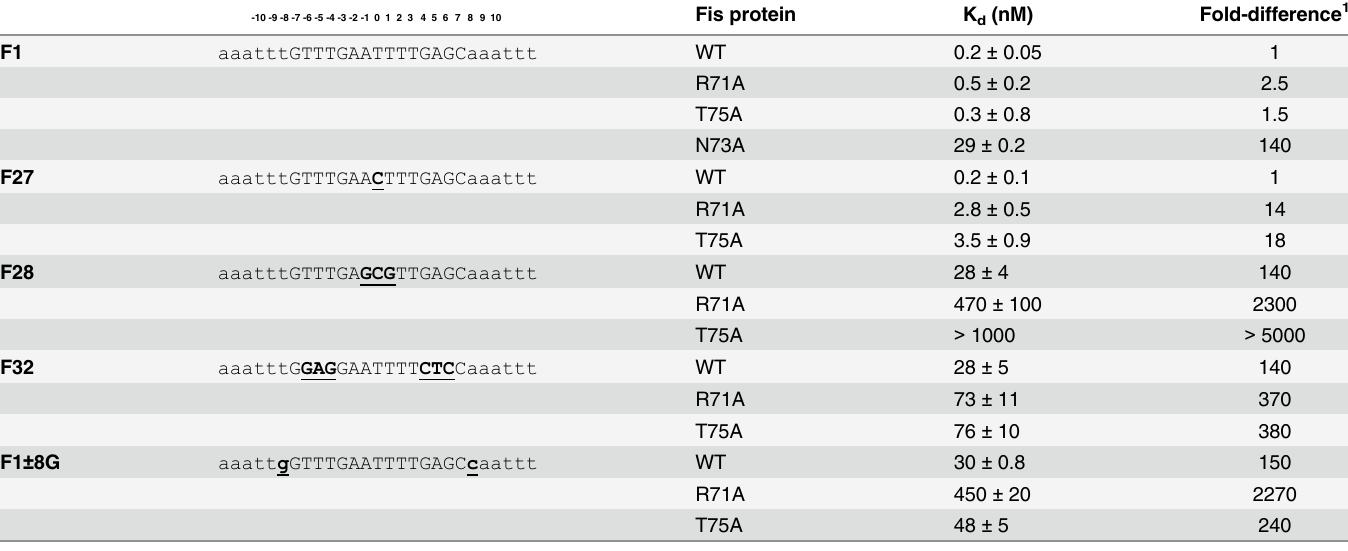
Table 3. Interplay between Fis residues contacting the flanking sequences and binding site